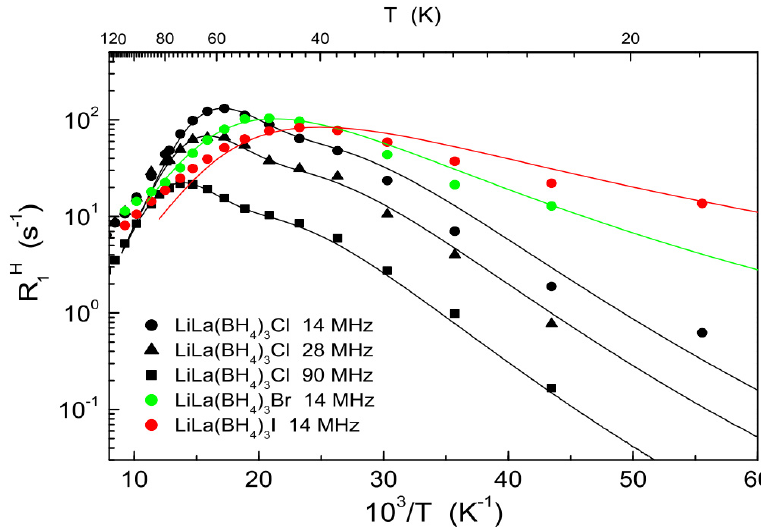
Figure 1. The behavior of the 1 H spin–lattice relaxation rates in LiLa(BH 4 ) 3 Cl [52], LiLa(BH 4 ) 3 Br, and LiLa(BH 4 ) 3 I [53] at low temperatures. The relaxation rates measured at di ff erent resonance frequencies are shown as functions of the inverse temperature. For LiLa(BH 4 ) 3 Br and LiLa(BH 4 ) 3 I, only the results at 14 MHz are included in the figure. The curves show the simultaneous fits of the two-peak model to the data for LiLa(BH 4 ) 3 Cl (black lines) and the model with a Gaussian distribution of activation energies to the data for LiLa(BH 4 ) 3 Br and LiLa(BH 4 ) 3 I (green and red lines, respectively).